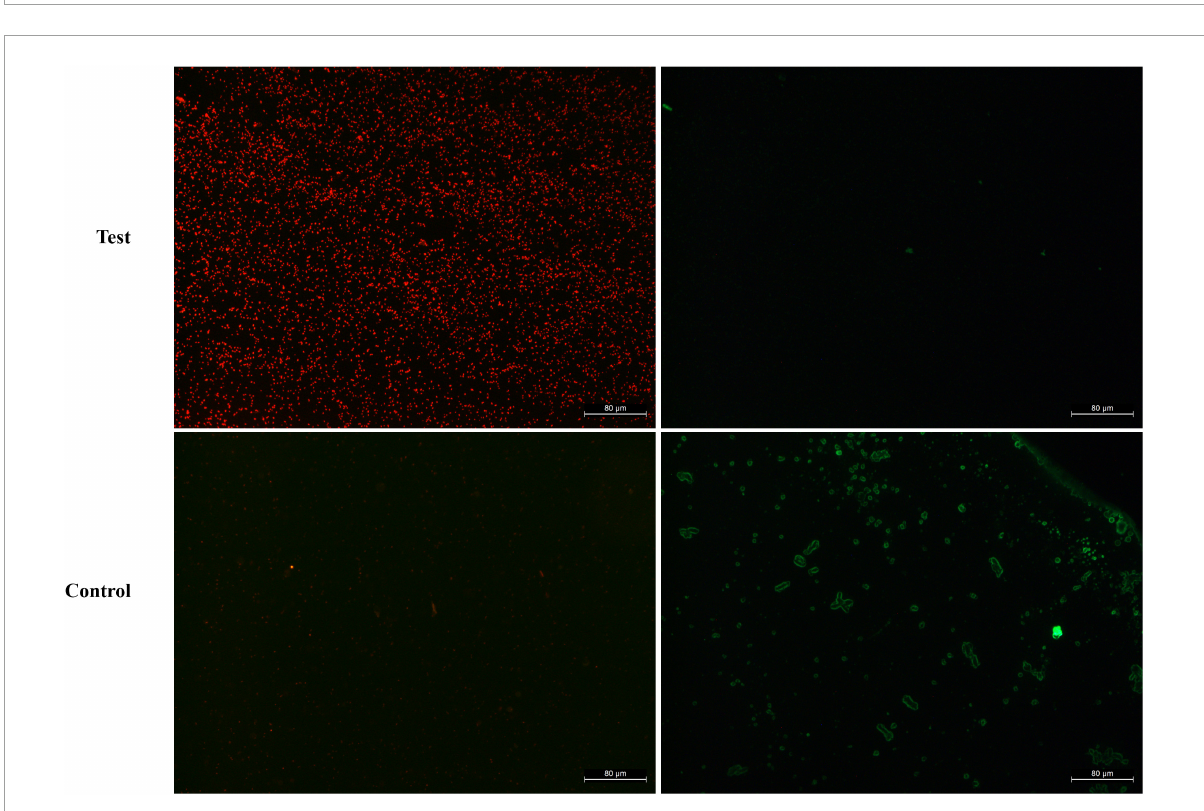
FIGURE8 Fluorescence microscopy analysis of propidium iodide (PI) uptake during the membrane permeabilization assay. Control and treated represent fluorescent images of E. coli cells treated with PBS and 2 × MIC BVYA1,